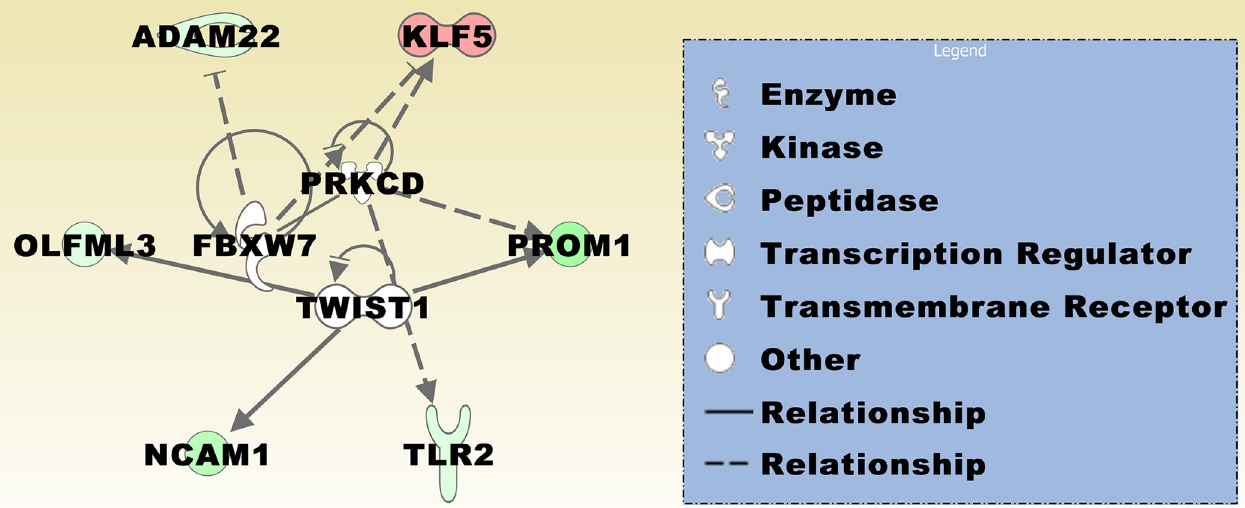
Fig 4. Upstream analysis of genes present in at least three different data sets from the DCC low vs . DCC high expression groups. The merged upstream regulator network contains the regulated genes/molecules, including PROM1, NCAM1, ADAM22, OLFML3, TLR2, and KLF5, and the three upstream regulators F-box and WD repeat domain containing 7 (FBXW7), protein kinase C delta (PRKCD), and twist family bHLH transcription factor 1 (TWIST1). See Fig 3 or Fig 5 for prediction legend.